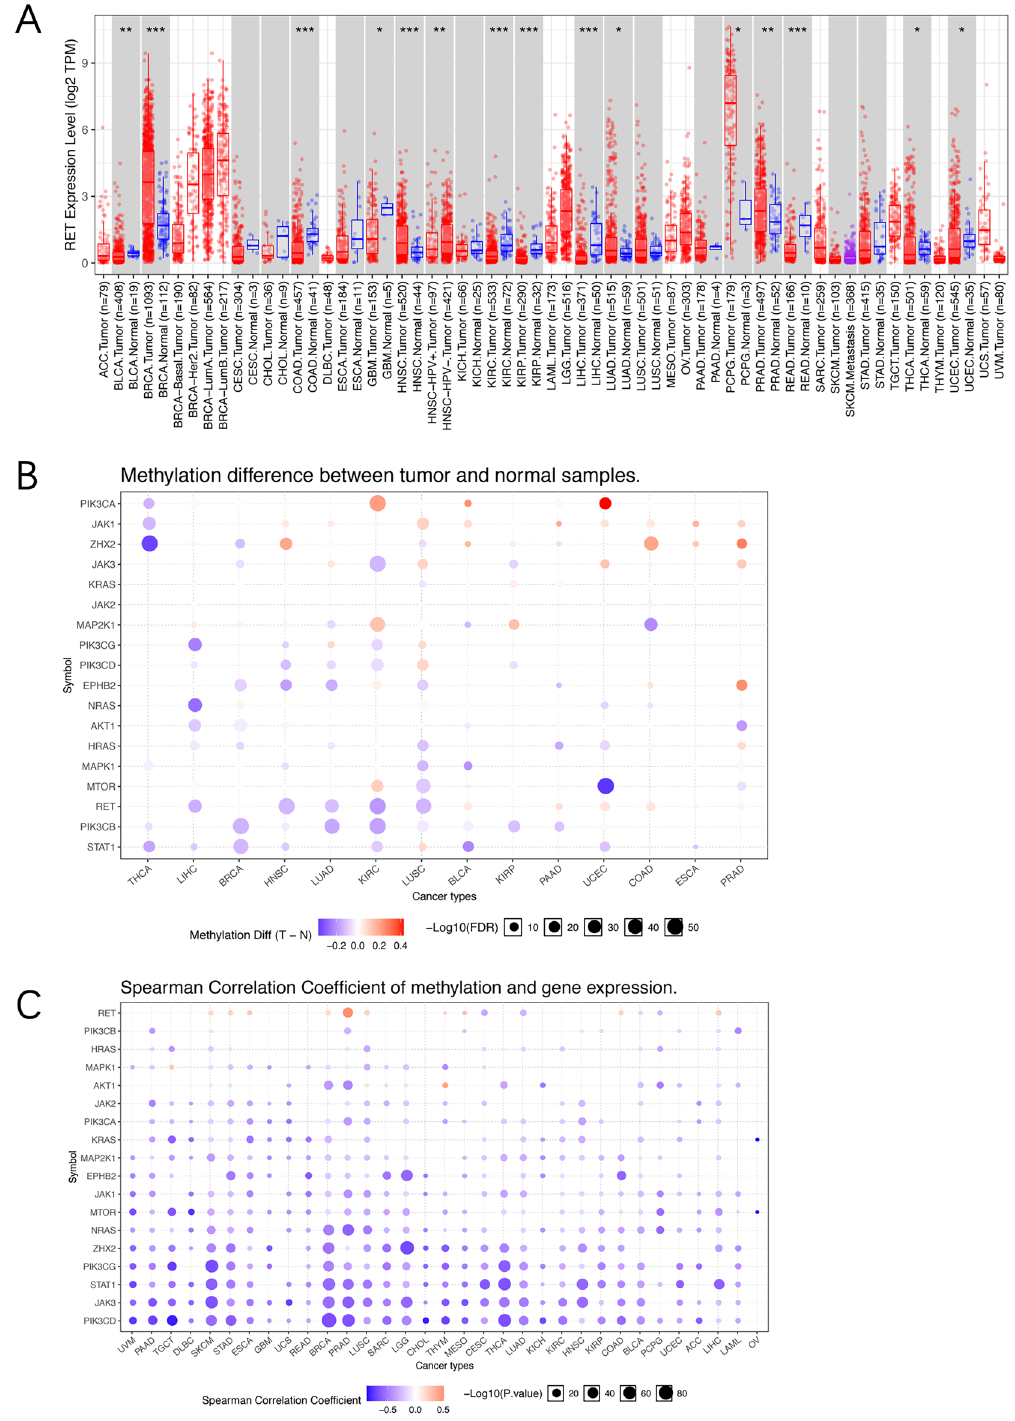
Figure 8. RET mRNA levels and methylation in TCGA cancers. ( A ) RET mRNA levels (log2 TPM transformed) between tumor tissues and the paired normal tissues among diverse TCGA cancers from TIMER2. ( B ) Bubble map illustrating the differences of RET and related downstream genes methylation between tumor tissues and corresponding normal tissues among cancers. Red dot: the upregulation of methylation in indicated cancers, blue dot: the downregulation of methylation in indicated cancers. ( C ) Bubble map depicting the relation between methylation and RET and its downstream genes expression in different TCGA cancers. Red dot: the increases in both methylation level and gene expression level, blue dot: the increase in methylation level but decrease in gene expression level. TPM transcripts per million. * p < 0.05, ** p < 0.01, *** p <